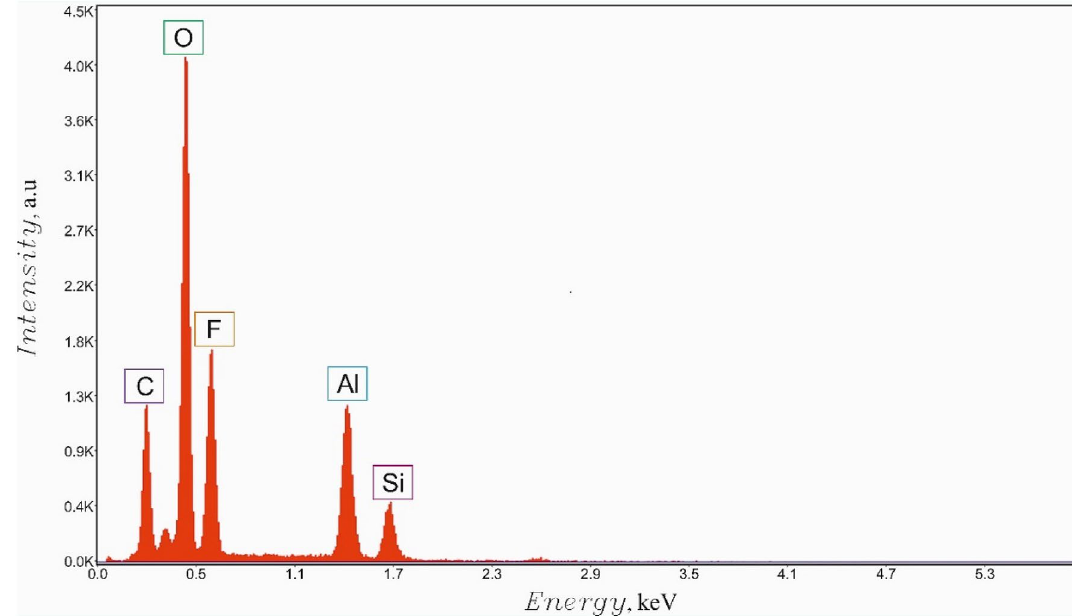
Figure 3. EDS analysis of the icephobic, omniphobic surface is supplied. The pronounced fluorination of the surface is